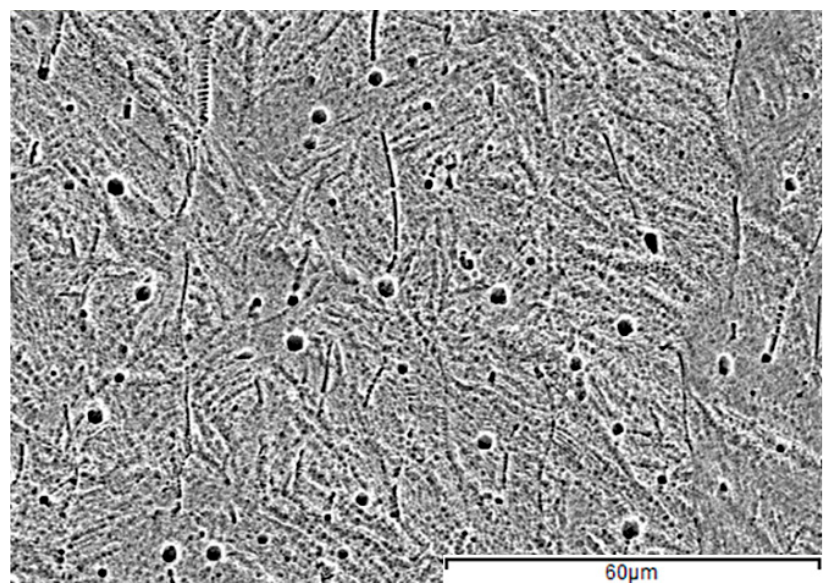
Figure 5. SEM image of the metal after heat treatment.